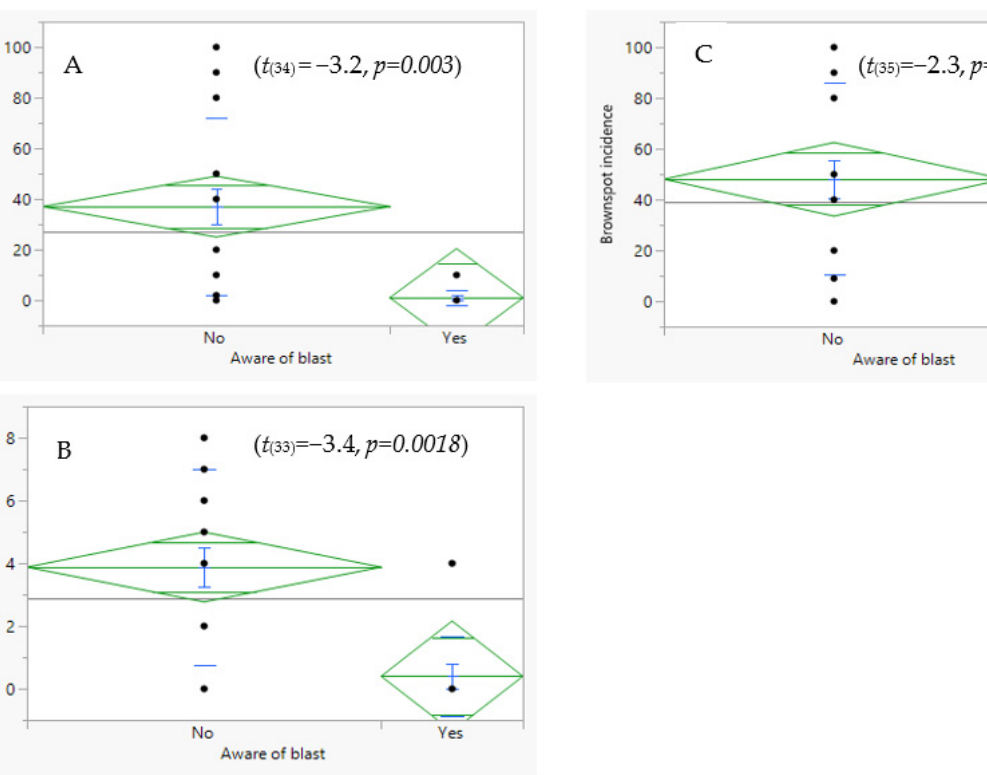
Figure 2. Blast awareness among the rice growers in irrigated and rainfed production systems in Busia and Kisumu counties of Kenya during 2019.